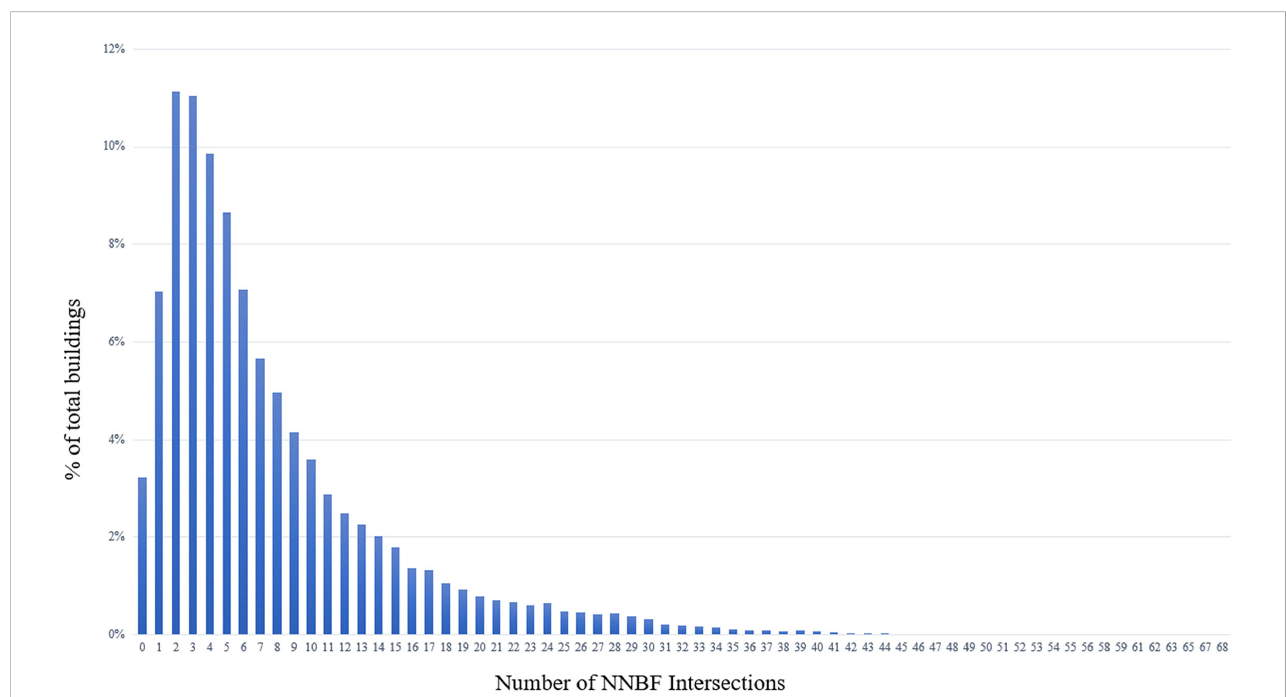
FIGURE 7 Buildings summarized by the number of NNBFs intersecting their